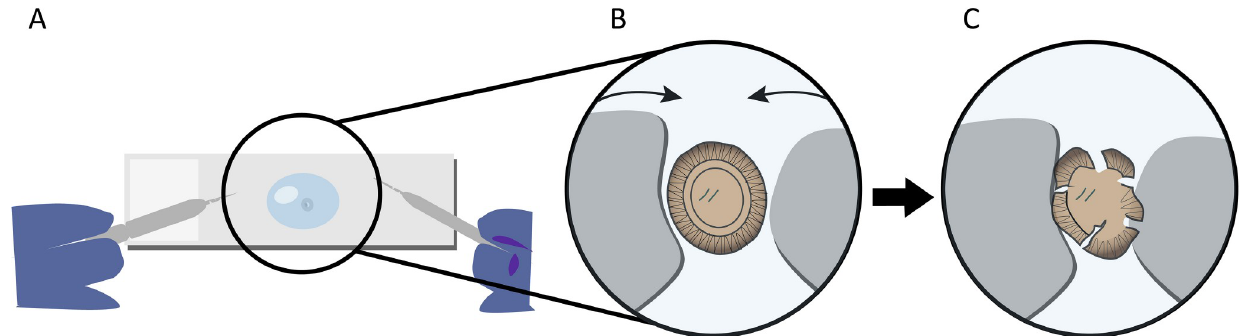
Fig 2. Disruption of Taenia eggs using self-made borosilicate needles. (A) Place a 4 μ L droplet of RNAse-free PBS on a fresh cover slide and add two Taenia eggs, (B) place the needles in the droplet and gently move them towards the egg, (C) then push the needles against each other with mild force until you can visually confirm the disruption of the